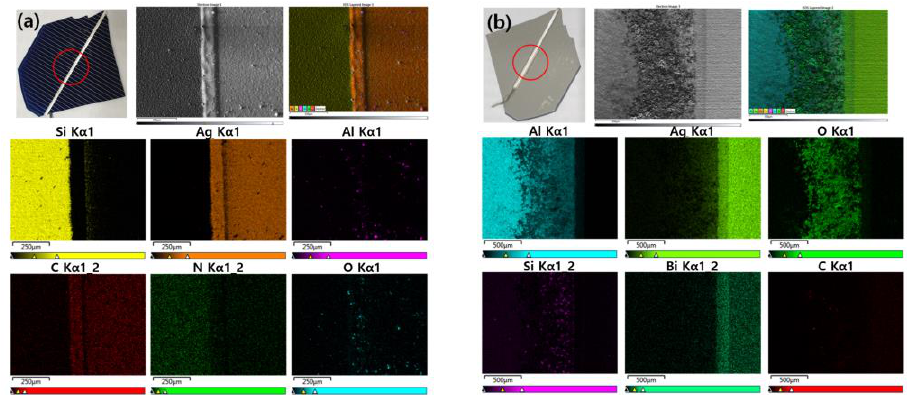
Figure 3. SEM mapping analysis of an end-of-life photovoltaic cell; ( a ) front side of the cell; ( b ) back side of the cell.